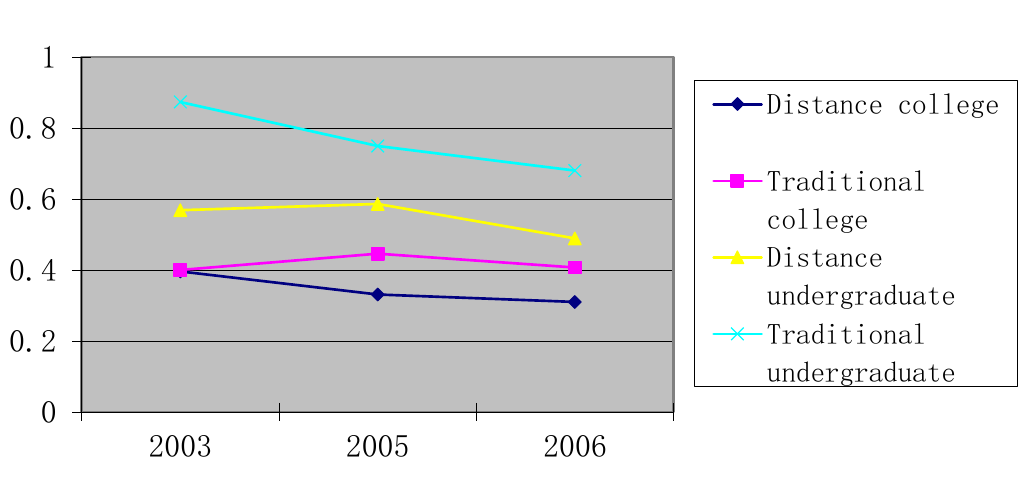
Figure 3. The change of returns of distance and traditional education from different educational